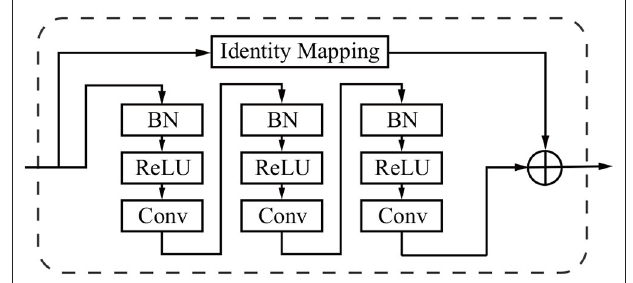
FIGURE 4 | Sample of a residual block in the dashed window. An identity mapping and convolutional blocks are added before the final feature output.